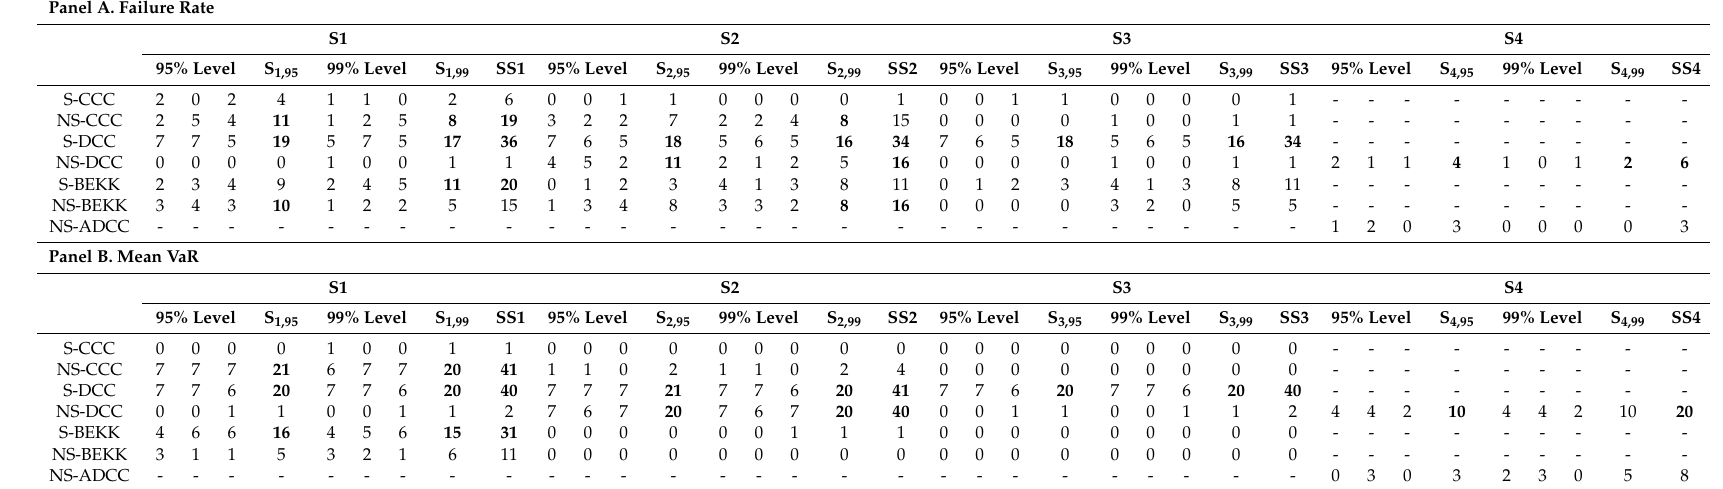
Table 5. The summary results for the out-of-sample VaR forecasts performance of equal-weight stock portfolios based on the mean VaR and failure rate. Panel A. Failure